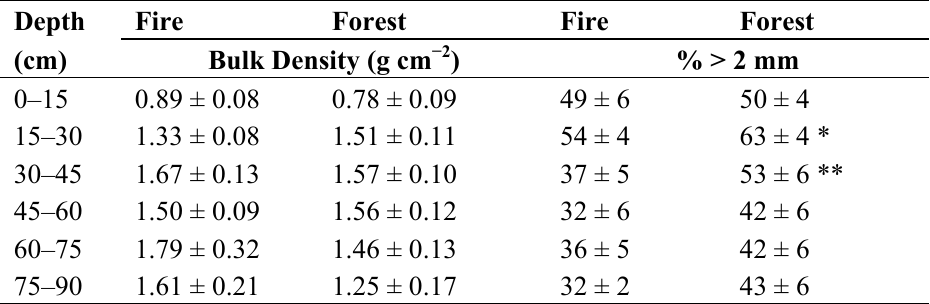
Table 1. Soil physical properties of adjacent former fire (Fire in 1960) and unburned forested sites at Sagehen, California.